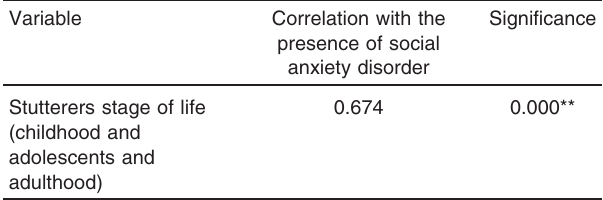
Table 5 Correlation between stutterers ’ stage of life and